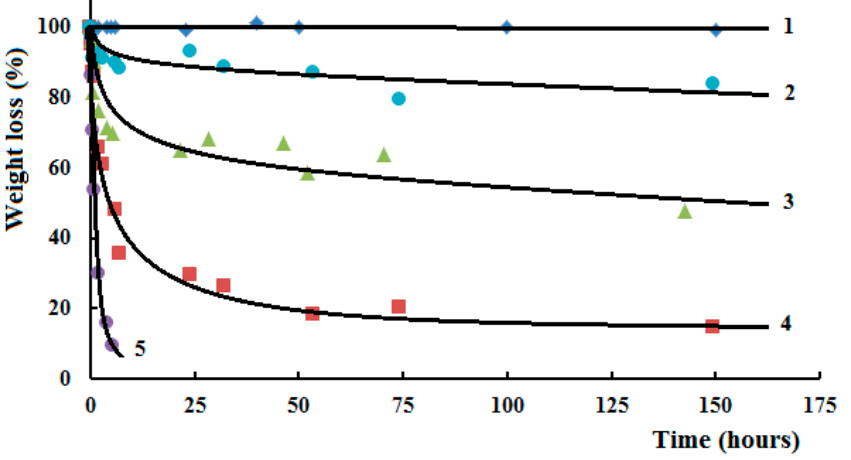
Figure 11. Weight loss of hydrochloride/apple pectin hydrogels: 1—distilled water; sodium phos- phate buffers with different pH: 2—pH = 6.4; 3—pH = 5.8; 4—pH = 7.4; 5—pH = 8.0. Data are expressed as mean ± SD; n = 3.